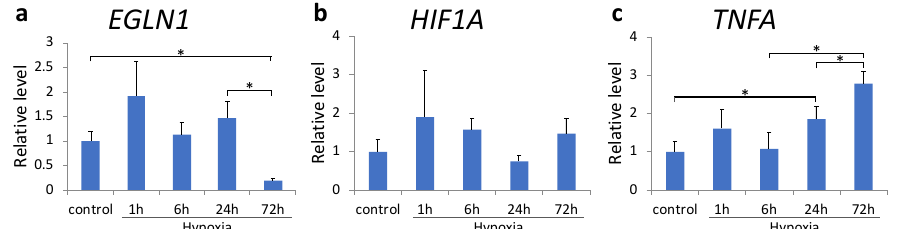
Figure 3. ( a – c ) EGLN1 ( a ), HIF1A ( b ), and TNFA ( c ) mRNA expression in MH7A cells was analyzed using quantitative reverse-transcription polymerase chain reaction after culturing under hypoxia (1% O 2 ) in the presence of deferoxamine. Each value represents the mean triplicate ± S.D. (n = 4); * p < 0.05.